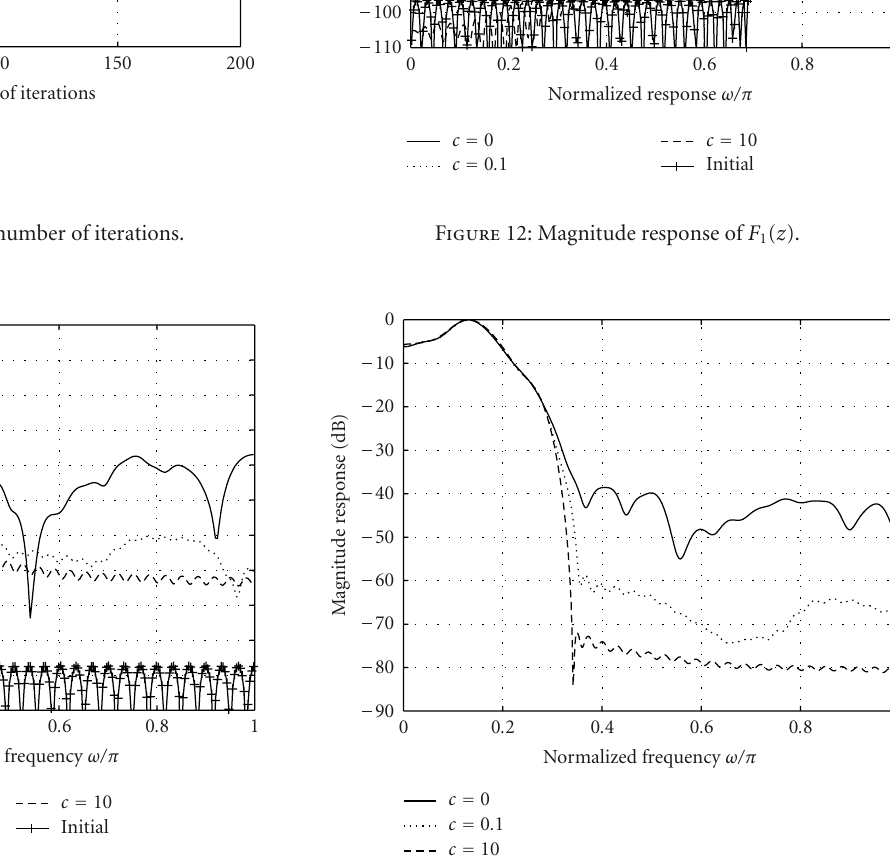
Figure 11: Magnitude response of F 0 ( z ).